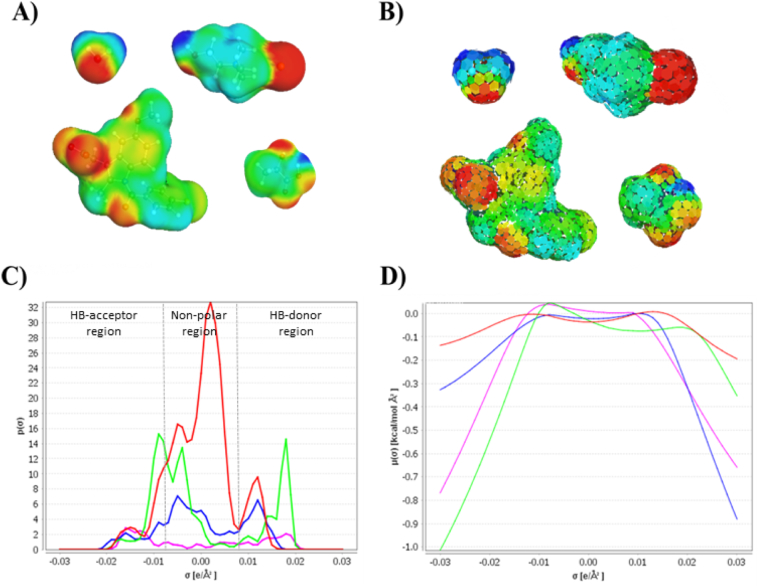
Schematic overview of the computational prediction process by COSMO-RS. A) The screening charge density (σ) and three-dimensional structure of for water Image 1, choline chloride Image 2, indomethacin Image 3, and lactic acid Image 4. B) A representation of the molecular segmentation of the molecule. C) The σ-profile of the solvent and solute. D) From the σ-profile the σ-potential is determined, which is used to calculate the chemical potential of a solution.